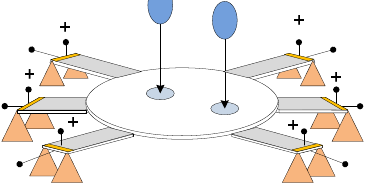
Figure 3. Larger piezoelectric harvesting systems with a floating circle.